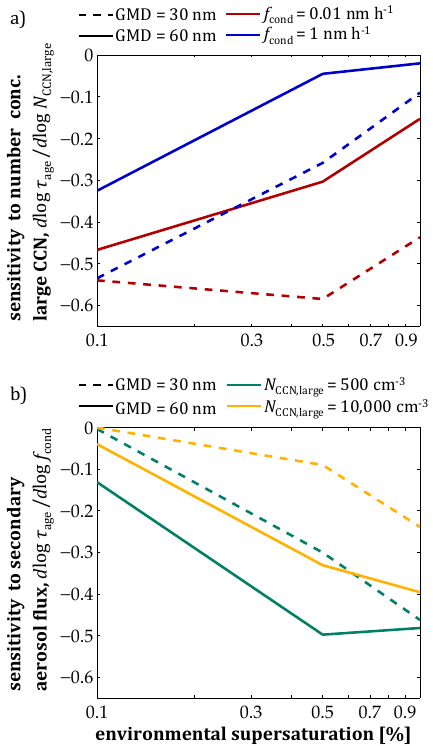
Figure 11. Sensitivity of aging timescale to (a) N CCN,large and (b) ˙ f cond as a function of supersaturation level, expressed as the log- arithmic derivative of the timescale with respect to each variable. The value of dlog τ age / dlog N CCN,large , for example, indicates the relative change in τ age to a relative change in N CCN,large . Shown for the size distributions and aging conditions in Fig.